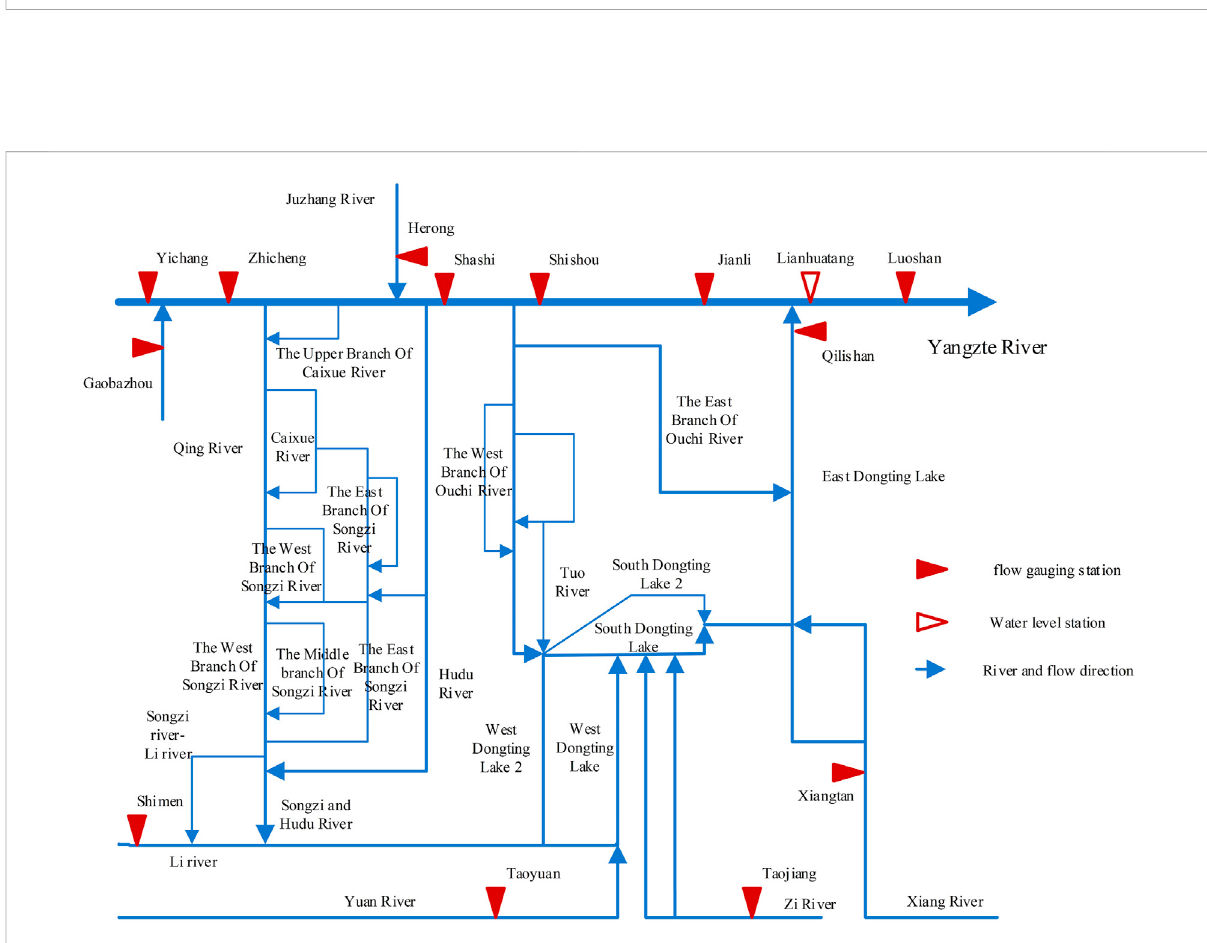
FIGURE 2 Outline of the MIKE11 hydraulic model for Jingjiang